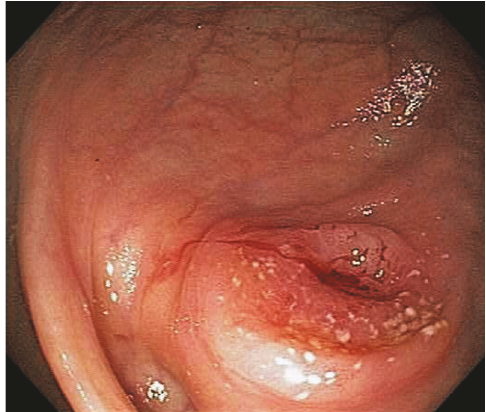
Figure 33: Endoscopic image of the cecum with “periappendiceal red patch” or “cecal